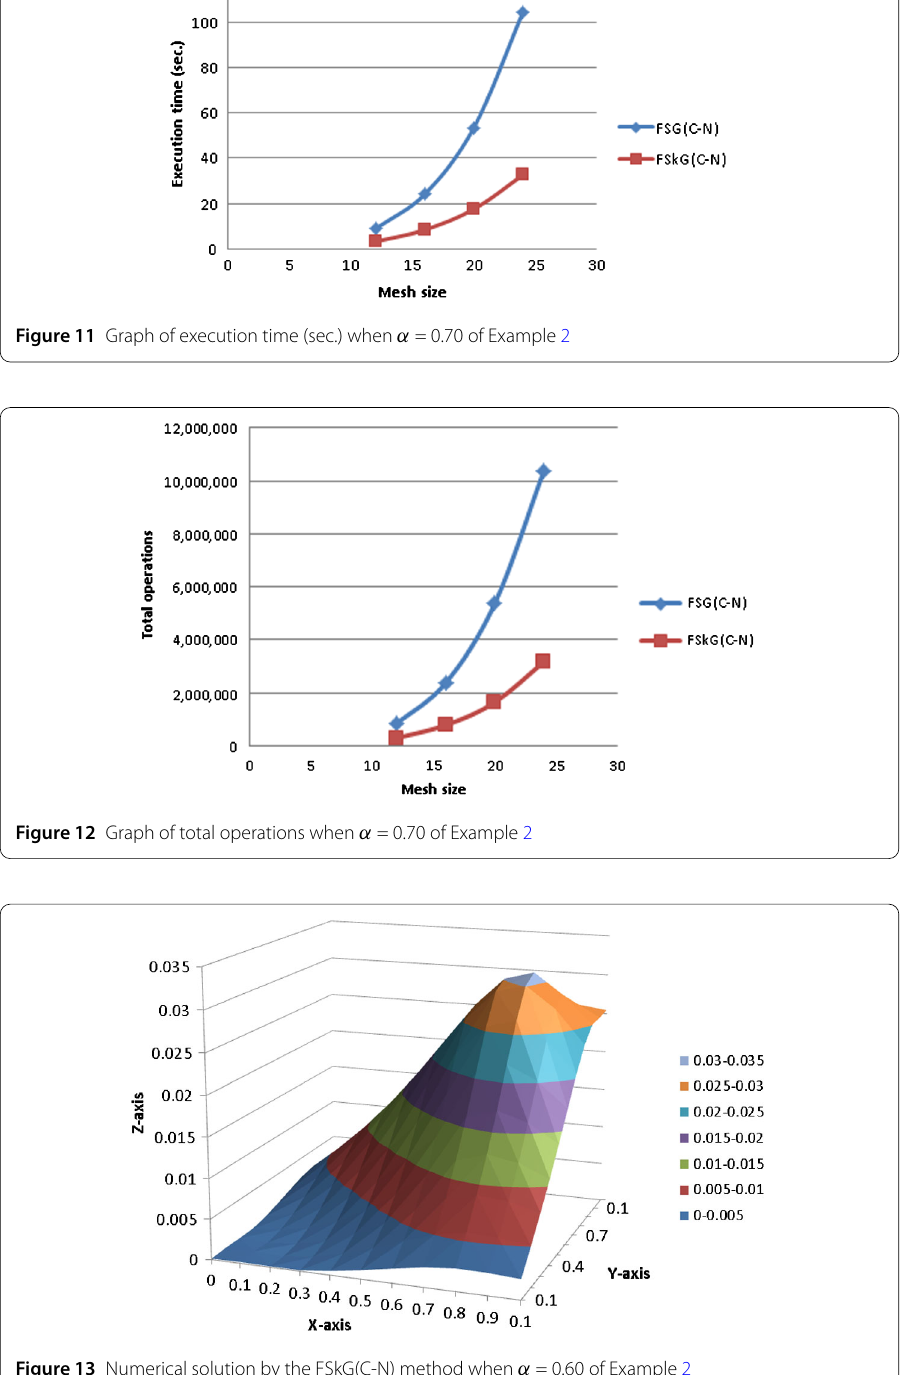
least number of arithmetical operations (per iteration) in terms of computational com- plexity, but it also requires least CPU execution timings (in seconds) and number of iter- ations (Ite) when compared to the FSG(C-N) iterative method without jeopardizing the solution